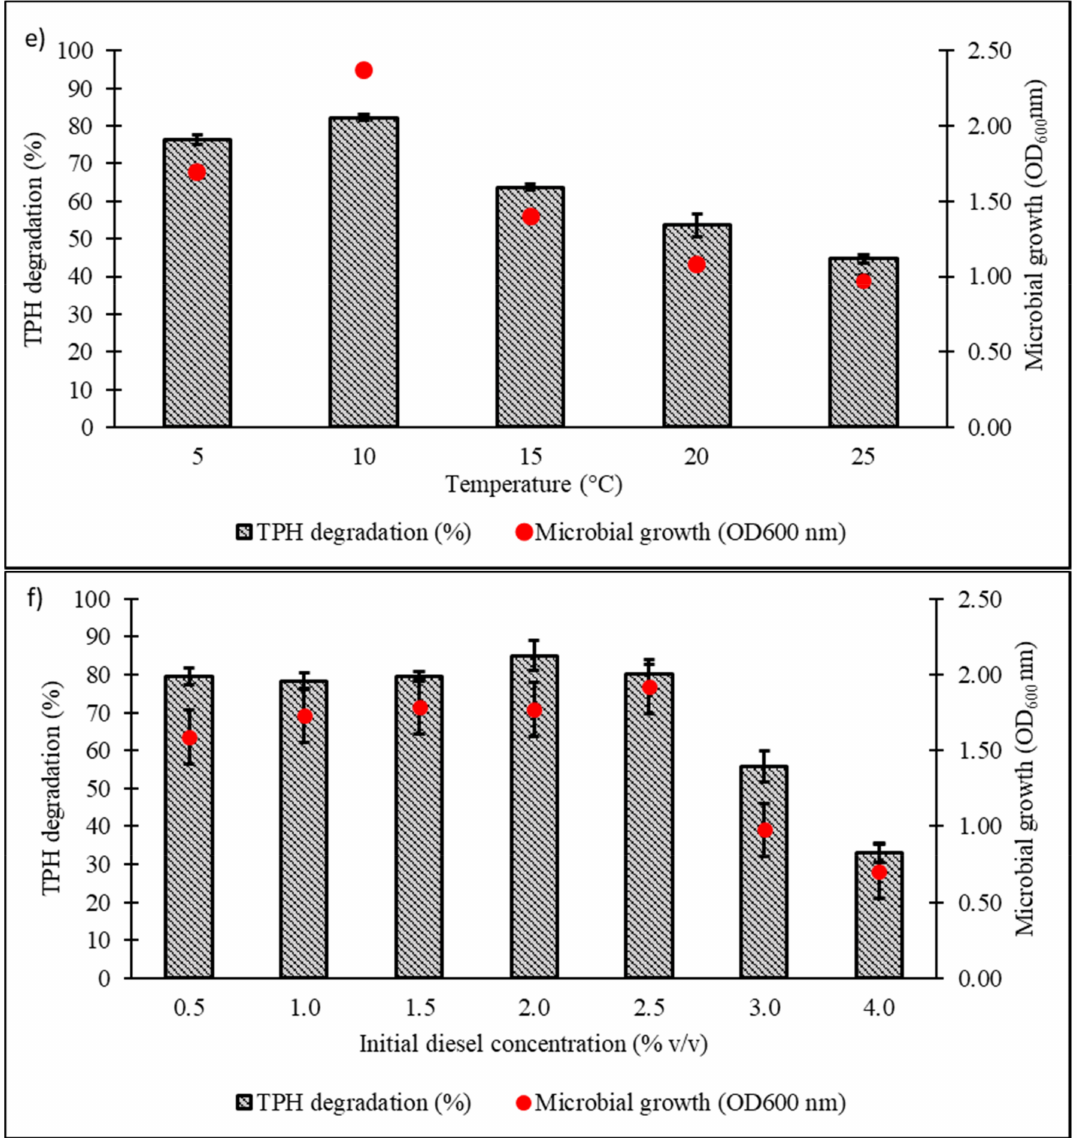
Figure 4. The effects of variation in levels of ( a ) NaCl concentration (% w / v ); ( b ) pH; ( c ) inorganic nitrogen source; ( d ) NH 4 Cl concentration (g/L); ( e ) temperature ( ◦ C); and ( f ) initial diesel concentration (% v / v ) on TPH degradation and microbial growth of consortium BS24 in 7-day incubation. Error bars represent the mean ± standard deviation for experimental